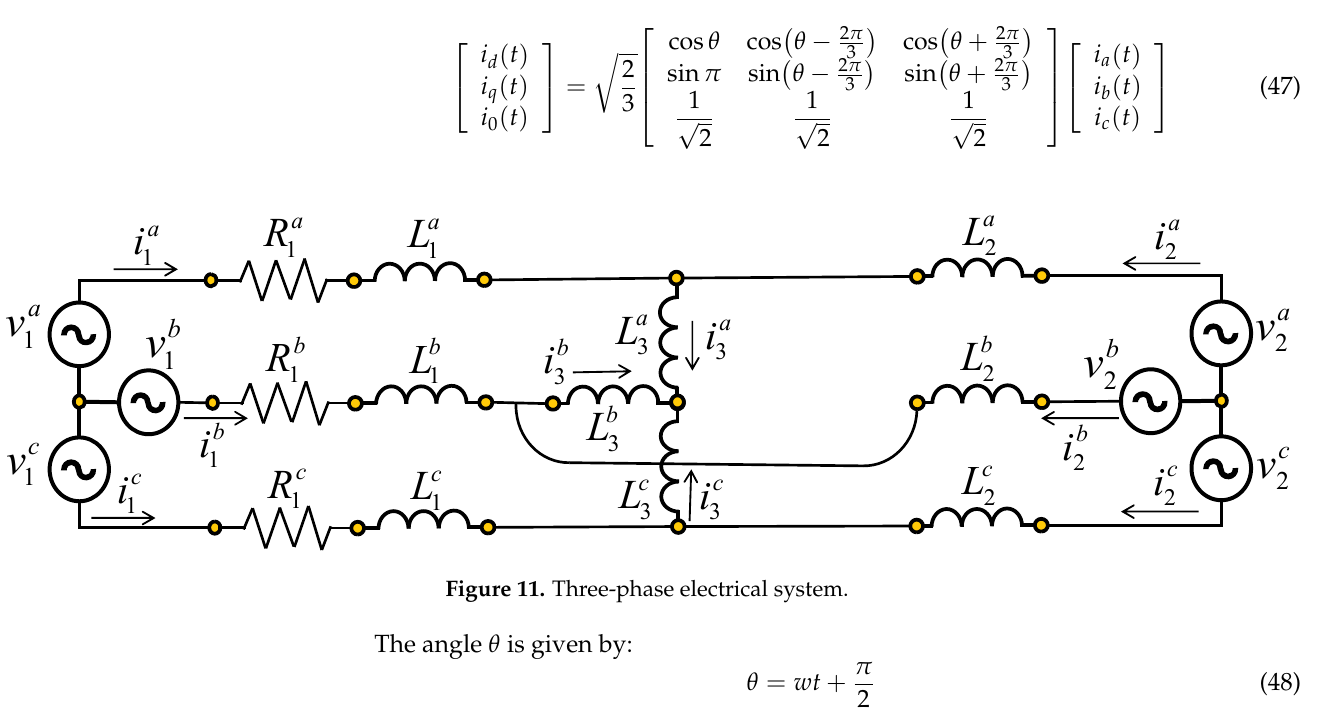
Figure 11. Three-phase electrical Fig. 9 . Three-phase